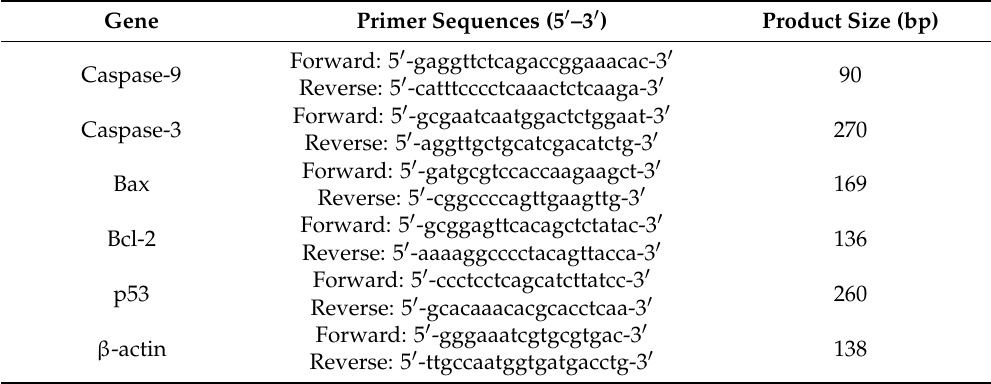
Table 1. The primer sequences for β -actin and other target genes of apoptosis